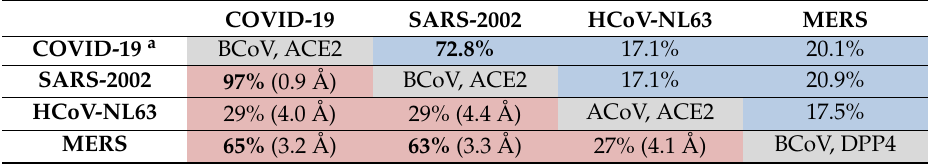
Table 1. The sequence and structural resemblance of the receptor-binding domains (RBDs) of various human coronaviruses.